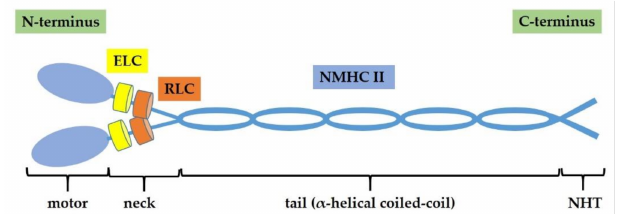
Figure 1. Non-muscle myosin II (NM II) structure. NM II is a hexamer composed by two non-muscle heavy chains (NMHC IIs) of 230 kDa, two regulatory light chains (RLCs) of 20 kDa, and two essential light chains (ELCs) of 17 kDa. NM II complex consists of three regions: motor domain, neck domain, and tail domain ( α -helical coiled-coil that terminates in a non-helical tailpiece, NHT). In their active conformation, NM II molecules interact antiparallelly by their tail regions and self-associate into NM II bipolar filaments with the motor domains oriented to the outside of the polymer